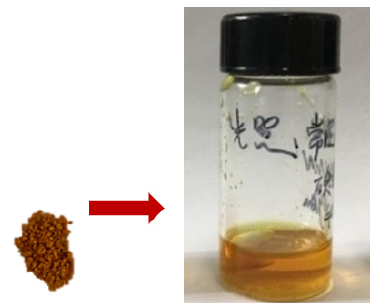
Figure 1. Gold dissolved in CHI 3 /BmimN(CN) 2 under light condition. Table 1. Gold leaching yield with different reagents and